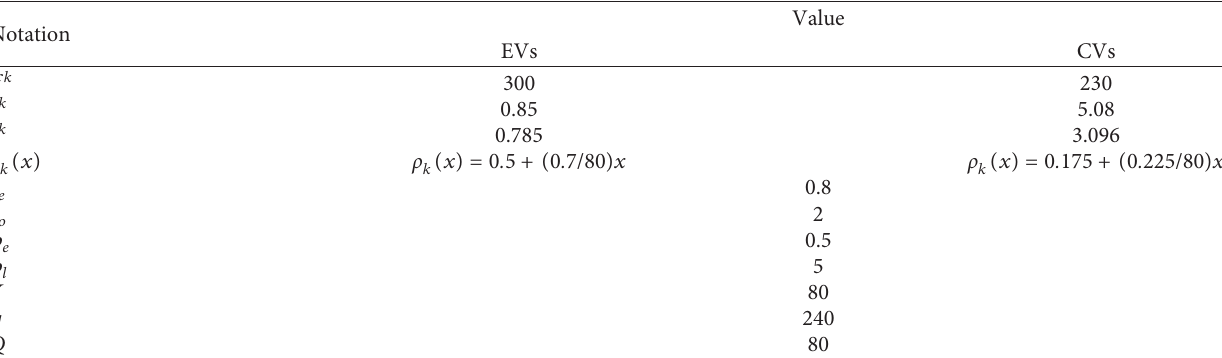
Table 4: Values of parameters in the